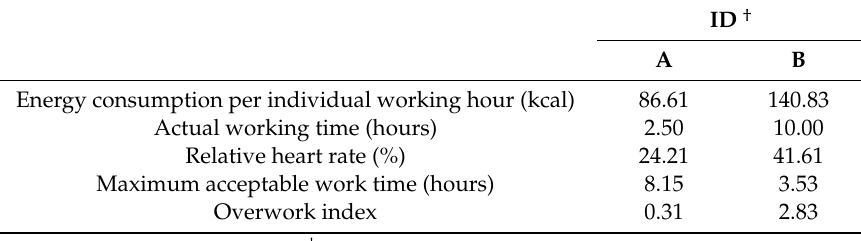
Table 4. Energy consumption and heart rate related result per individual working